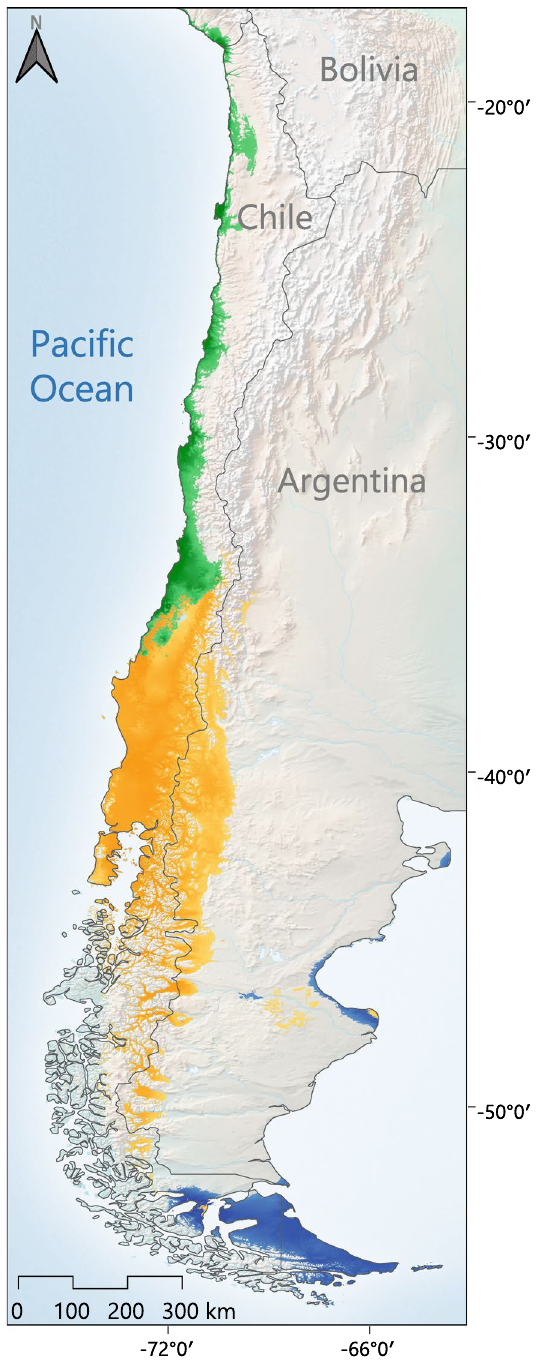
Figure 5. Potential geographic distributions of three of the mitochondrial phylogroups of Abrothrix olivacea as estimated from the projection of the upper values (0.55–1) of climatic suitability in the Current climatic conditions (1960–1990). Colored shading areas represent the climatically suitable areas estimated for the phylogroups N-Ch (green), CS-Ch-Ar (yellow), and TdF-SCh (blue), and the intensely colored zones correspond to those where the climatic conditions are optimal for each